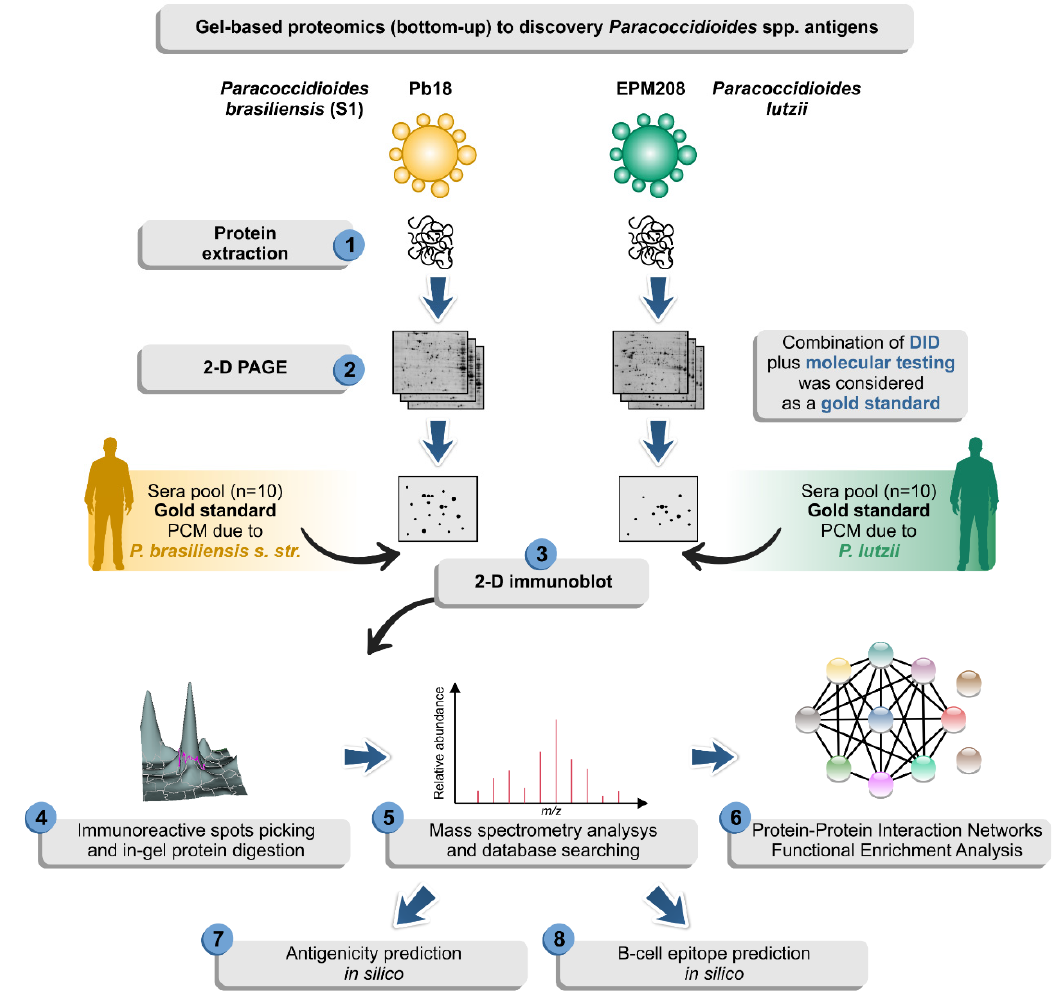
Figure 1. Diagram depicting a two-dimensional (2-D) proteomic approach followed by 2-D immunoblot used in this study in an attempt to identify possible antigens of Paracoccidioides species. The isolate EPM208 of P. lutzii was selected based on previous experiments showing that patients with P. lutzii mycosis show 100% reactivity with antigenic preparations from this strain [22]. The classical isolate Pb18 (S1) was used for comparison in the immunoproteomics experiments [54]. Afterward, the yeasts were used to prepare protein extracts (step 1) and then resolved by 2-D gel electrophoresis (step 2). Proteomes were transferred to membranes and probed against sera from patients with confirmed paracoccidioidomycosis (PCM) due to P. lutzii or P. brasiliensis (S1) (step 3). We consider as gold standard serum, the samples that presented positive double immunodi ff usion (DID) results and where it was possible to isolate the strain from the patient, following molecular characterization of this isolate. Therefore, only a paired serum: strain was used in the 2-D immunoblot. IgG-reactive proteins (step 4) were identified by mass spectrometry (step 5). Finally, a solid bioinformatic characterization of the immunoreactive protein was employed to highlight potential biomarkers for diagnosis of paracoccidioidomycosis due to P. lutzii (steps